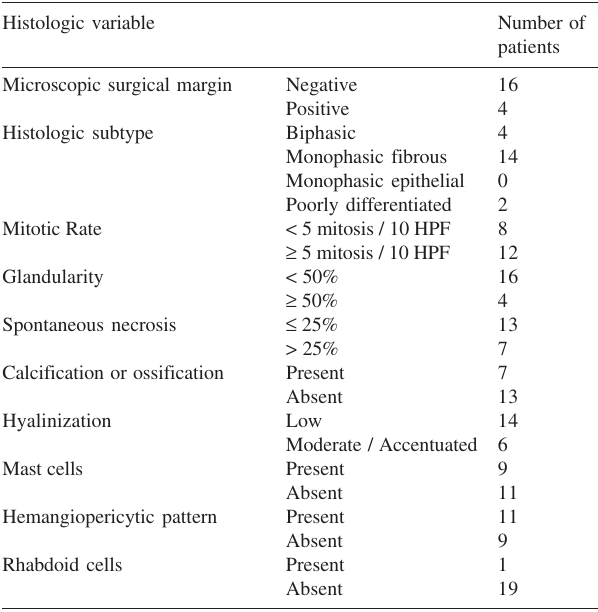
Table 1 - Patients distributed according to age, gender, anatomic site, and date of